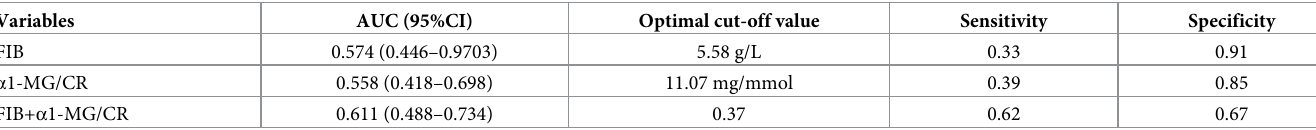
Table 4. Power of joint FIB and α 1-MG/CR in identifying advanced DKD by ROC curves.